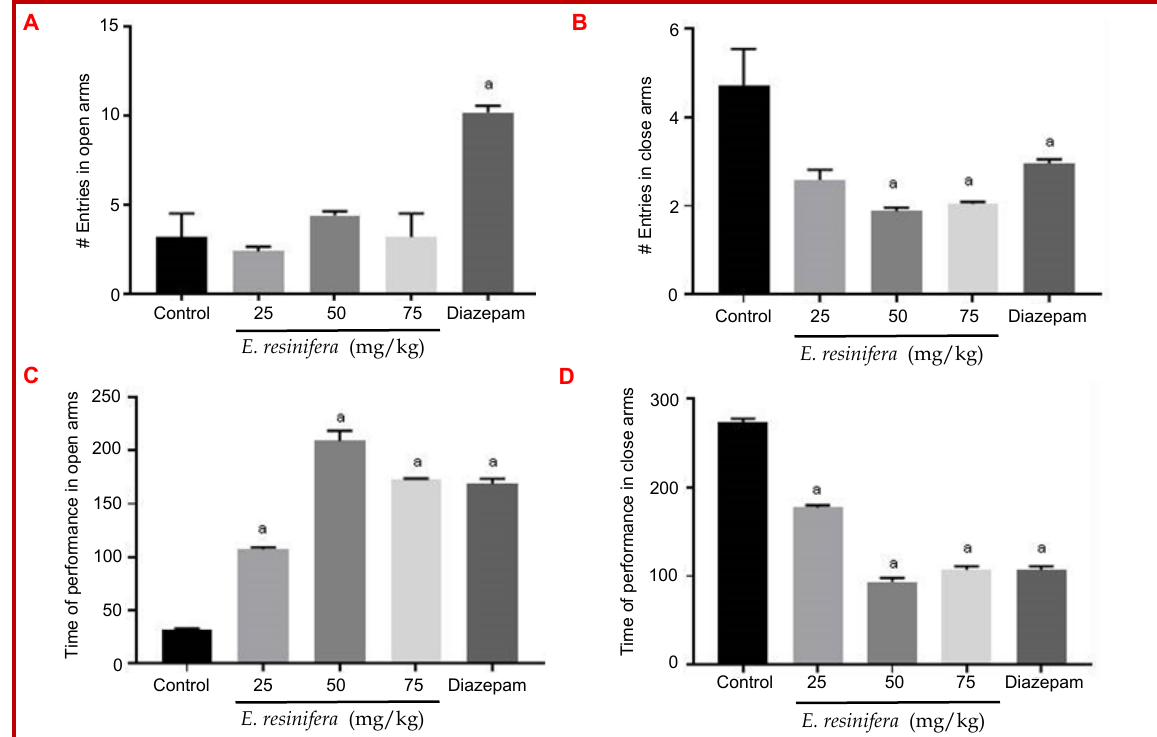
Figure 1: Effect of aqueous latex extract of Euphorbia resinifera and diazepam (2 mg/kg) in elevated plus maze test in mice (n=6 per group). The values are expressed as mean ± SEM, superscript ‘a’ indicates p<0.05 statistically significant difference between con- trol and treated groups. According to one- way ANOVA followed by Tukey’s